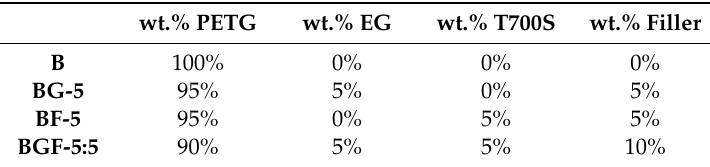
Table 2. Overview of prepared recycled PETG composite